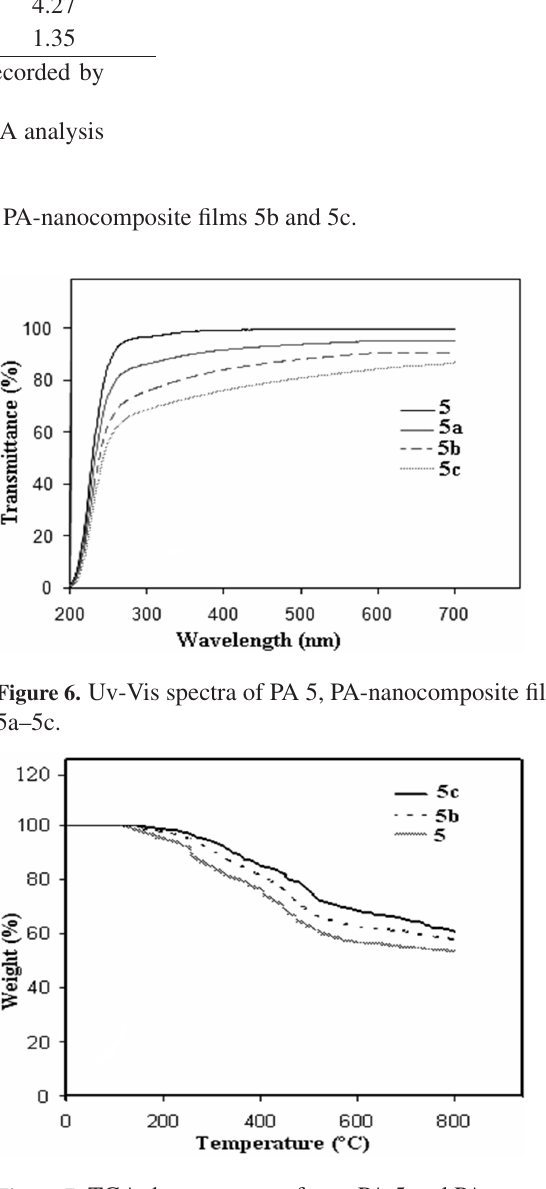
Figure 7. TGA thermograms of neat PA 5 and PA- nanocomposite films 5b and